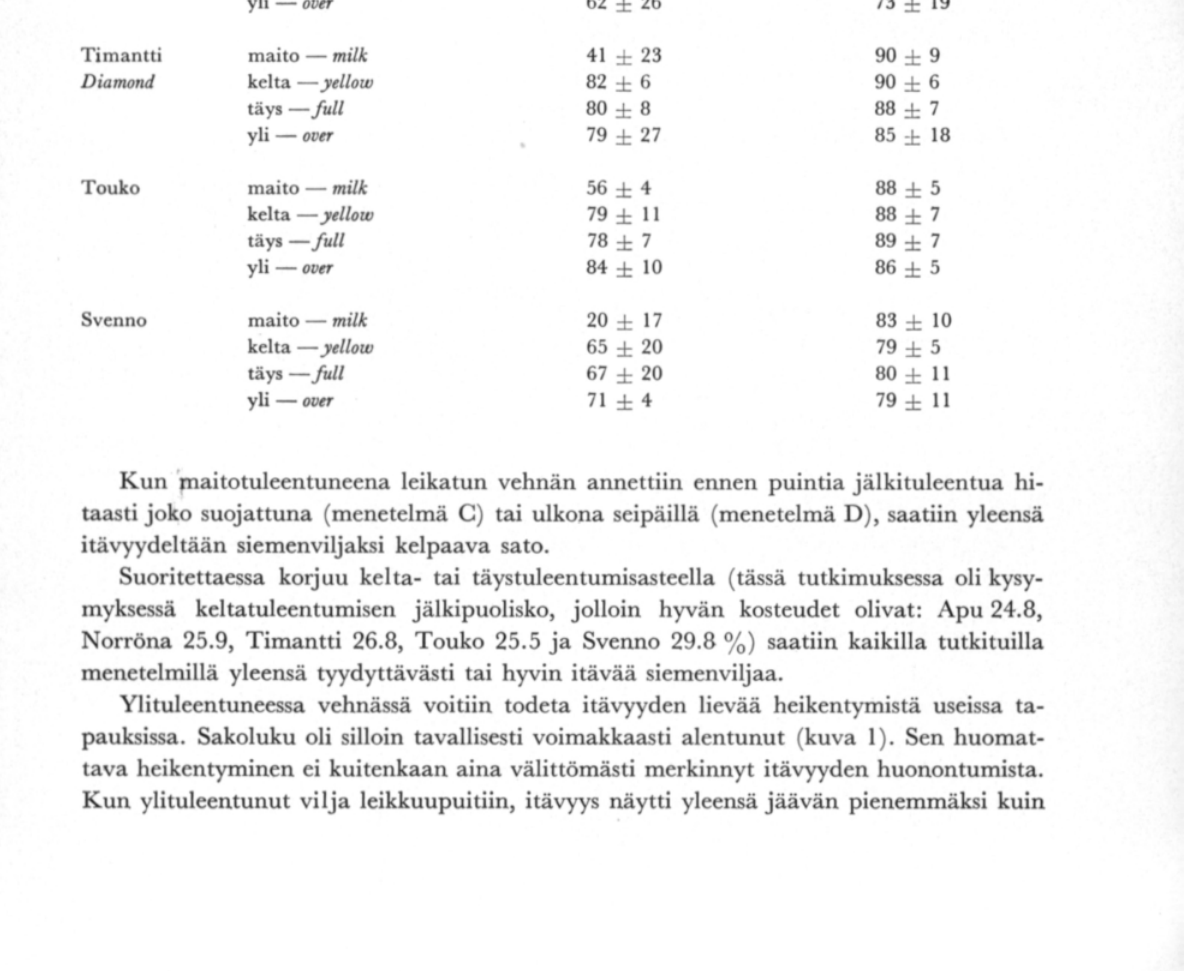
Table 2. Effect of harvesting time upon the germination of spring wheat cultivars harvested by various methods. The germination is expressed as percentages with 95 % confidence limits. The numbers are averages for the experimental years.